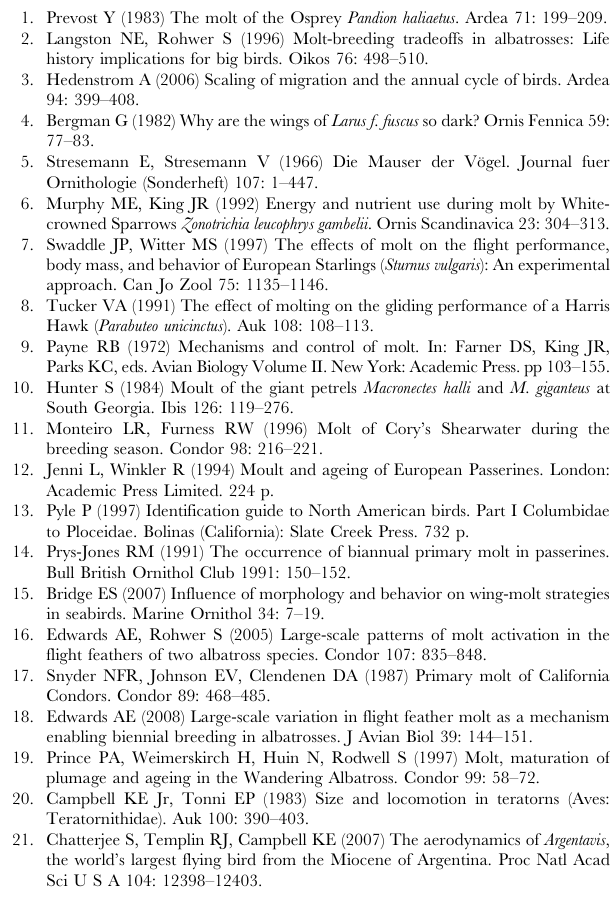
Table S1 Species and numbers of adults used to assess completeness of molt for Figure